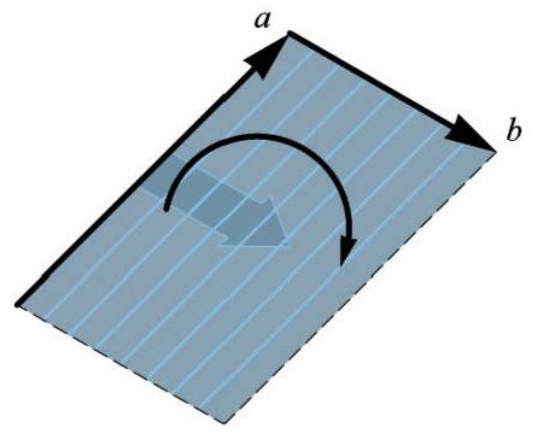
Figure 10: Vector decomposition in two-dimensional